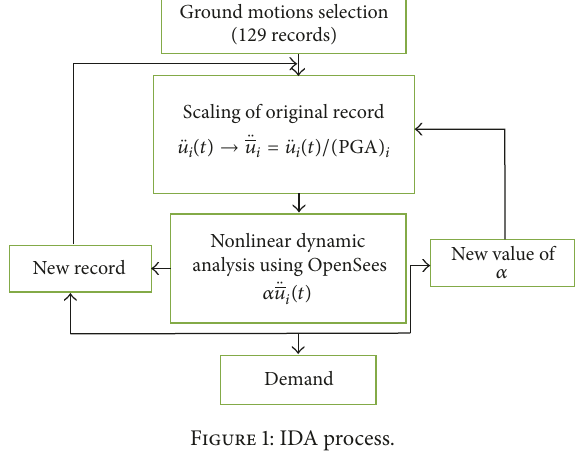
Figure 1: IDA process.